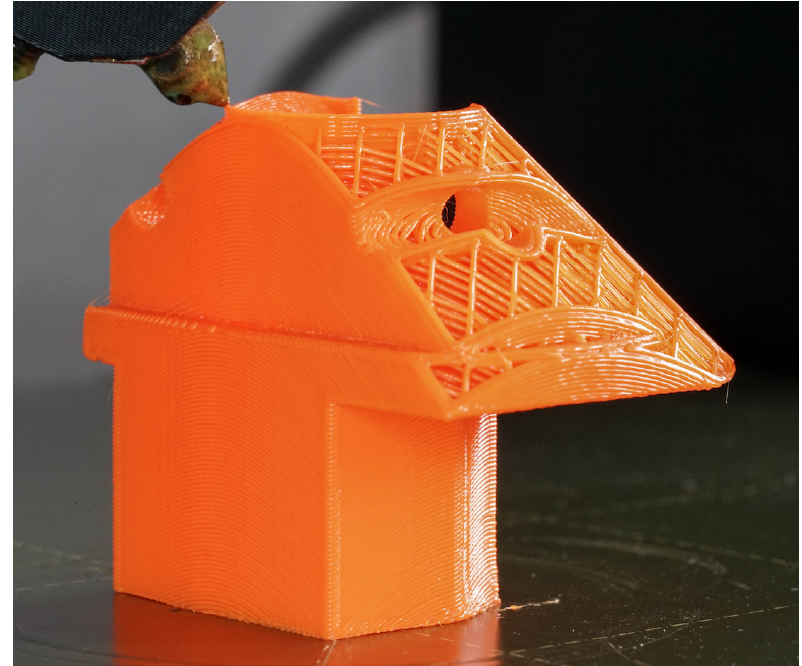
Figure 14. Part with outside overhang and holes being